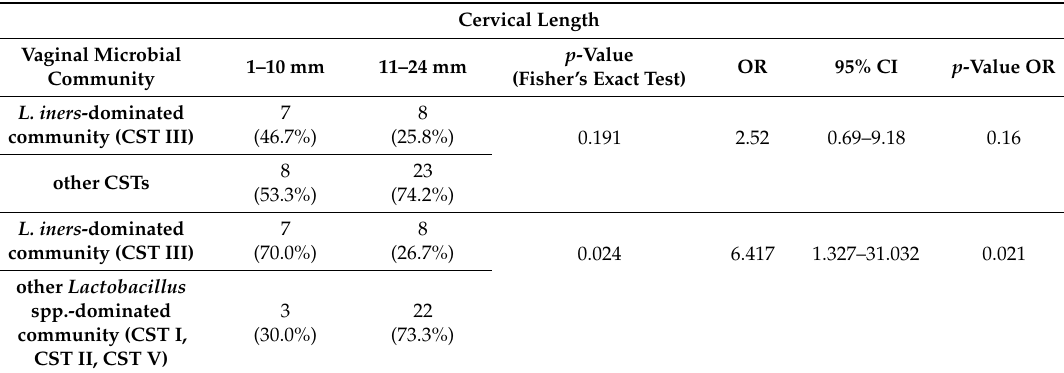
Table 3. Association of CSTs and cervical shortening categorization. Cervical